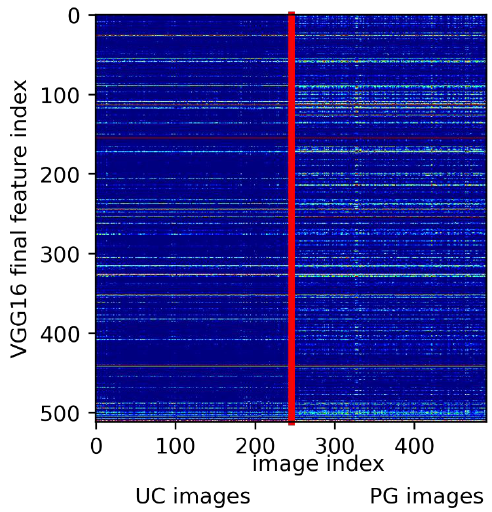
Figure 3. Extracted feature activations from the final VGG16 layer ( y -axis) for all 491 images. Image indices ( x -axis) were grouped in UC and PG ground truth. The vertical red line indicates the split between UC and PG diagnosis. Clearly, PG comes with the distinct expression of characteristic features, whereas UC shares features with PG.